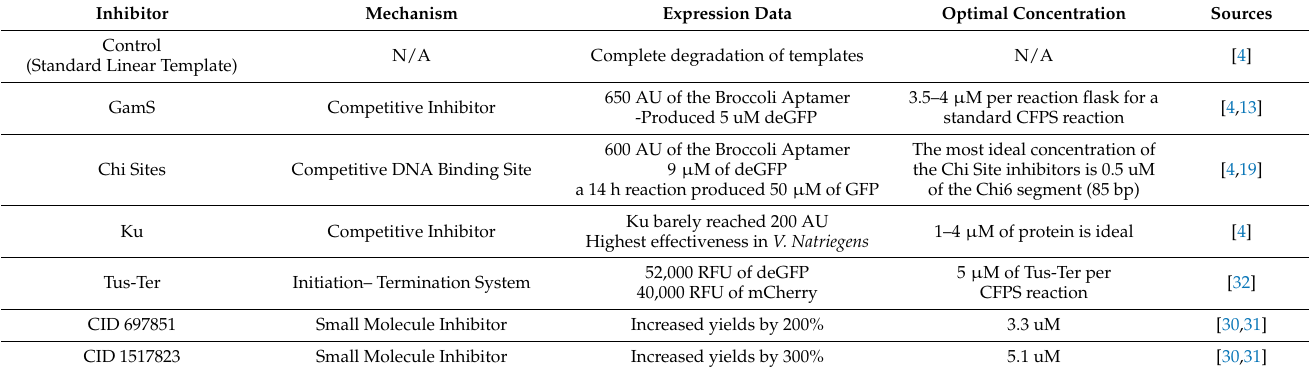
Table 1. List of Exonuclease V inhibitors, LET expression data, and optimal concentrations and specific mechanisms for GamS, Chi, Ku, CID 697851, CID 1517823, and Tus Ter mediated protection of